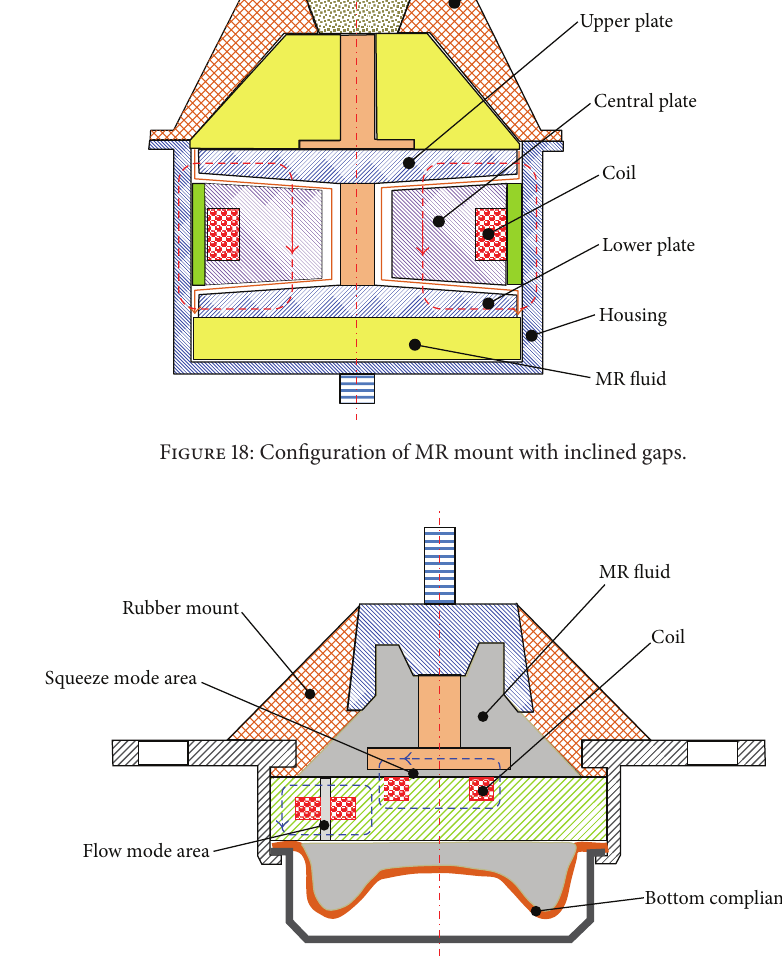
Figure 19: Configuration of the mixed mode MR